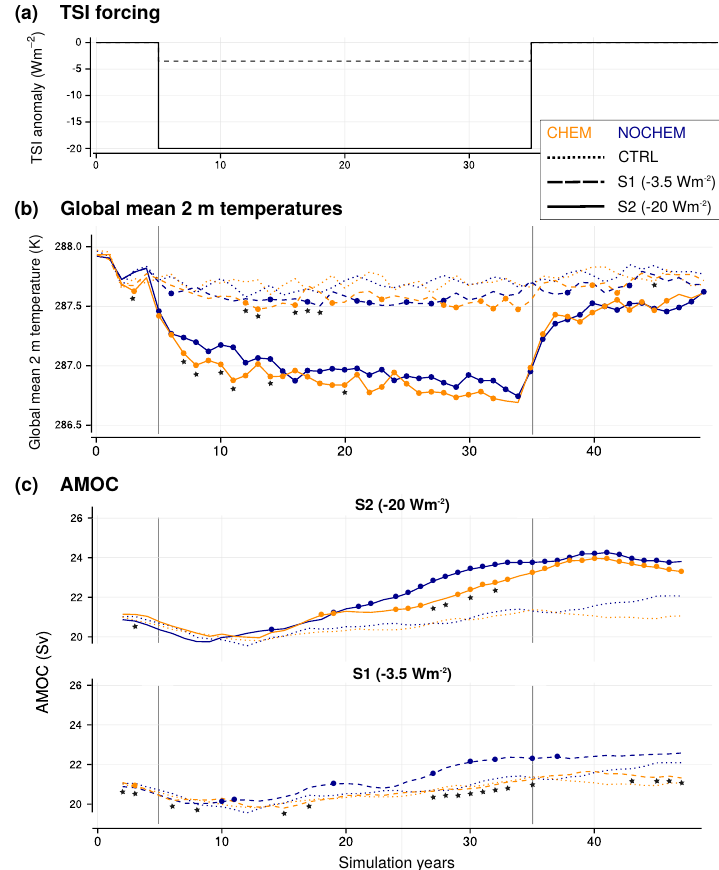
Figure 1. (a) Total solar irradiance (TSI) anomaly of − 3.5Wm − 2 (dashed) and − 20Wm − 2 (solid) applied in this study. (b) Global annual mean ensemble mean 2m temperature. (c) Ensemble mean AMOC index in the different experiments, smoothed using a 5-year running mean. Dots denote significant differences in the (un-smoothed) annual mean values between the SRR ensemble and the control ensemble (Student’s t test, p ≤ 0.05). Small stars below the CHEM time series correspond to years with significant differences between the CHEM and NOCHEM experiment ( p ≤ 0.05). The beginning and the end of the SRR period are indicated by vertical lines in panels (b) and (c)